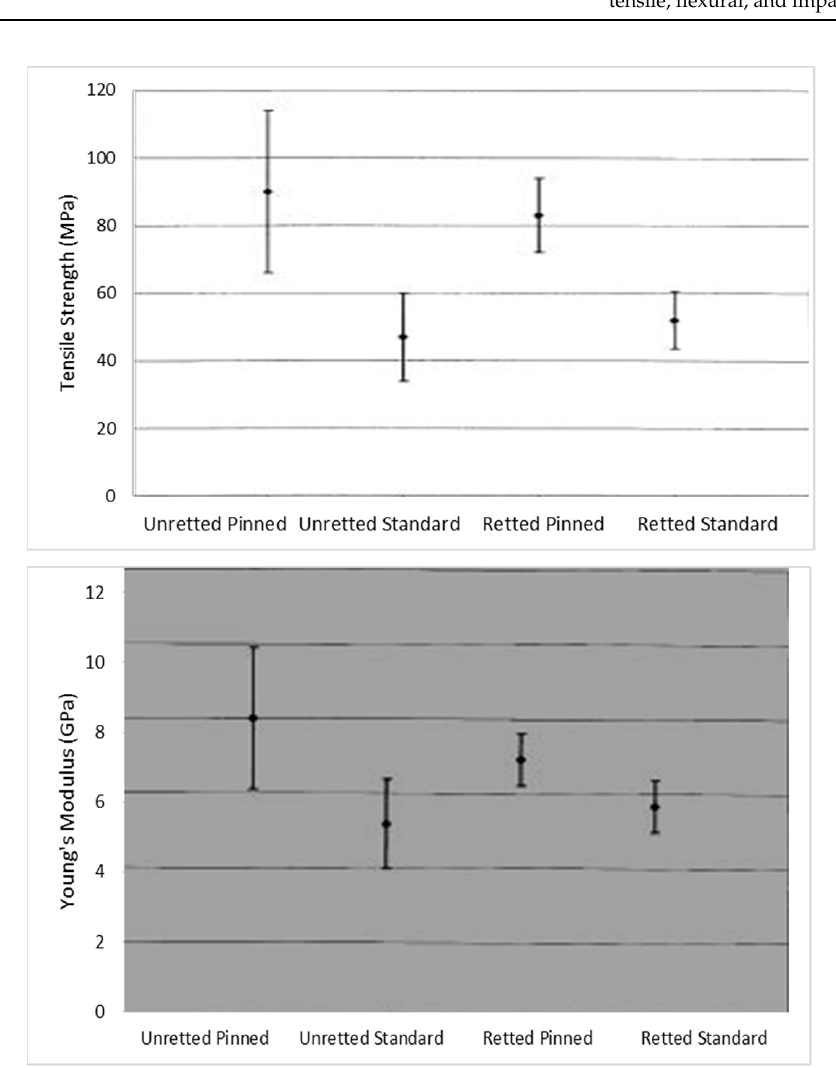
Figure 3. Showing the tensile properties of hemp (retted and unretted)–epoxy composites. Reprinted/adapted with permission from Hepworth DG et al. (2000) [117].